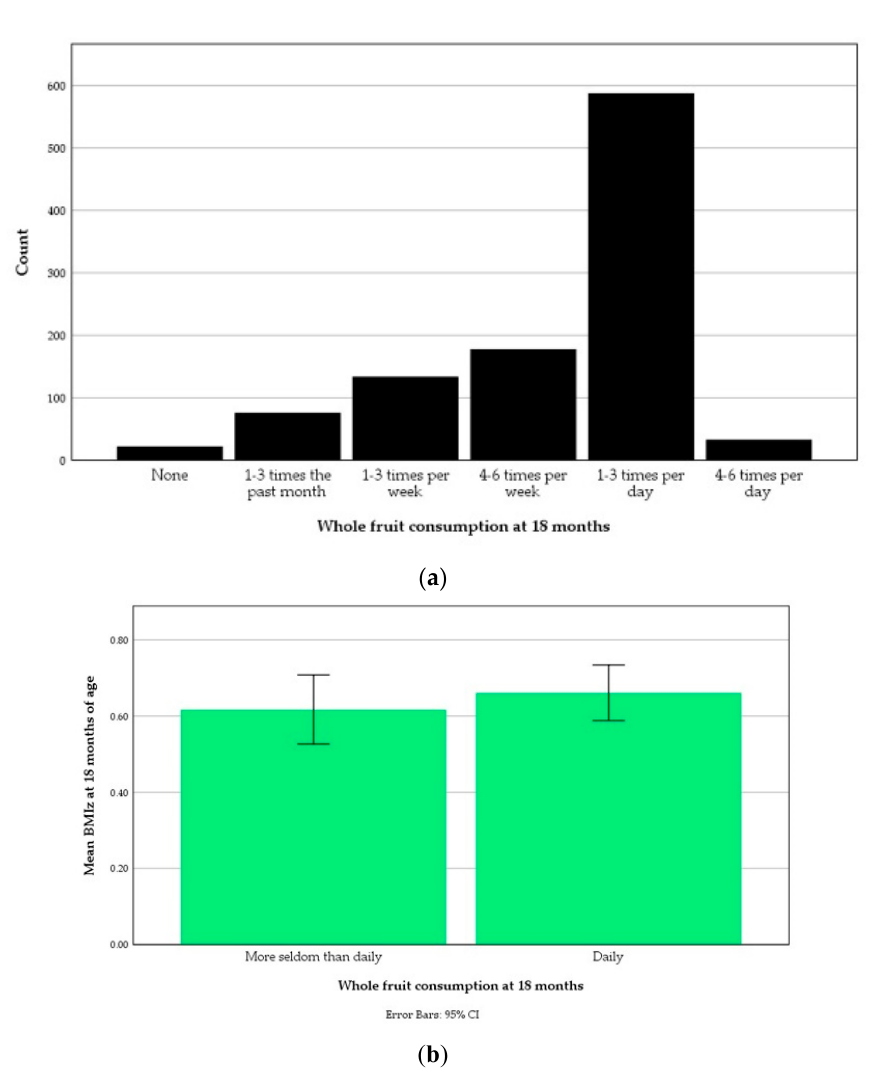
Figure 5. Whole fruit consumption during the past month at 18 months of age: ( a ) Distribution according to one-month-recall food frequency questionnaire responses; ( b ) The means body-mass index z -score (BMIz) at 18 months of those who did not consume whole fruit daily and of those who did.